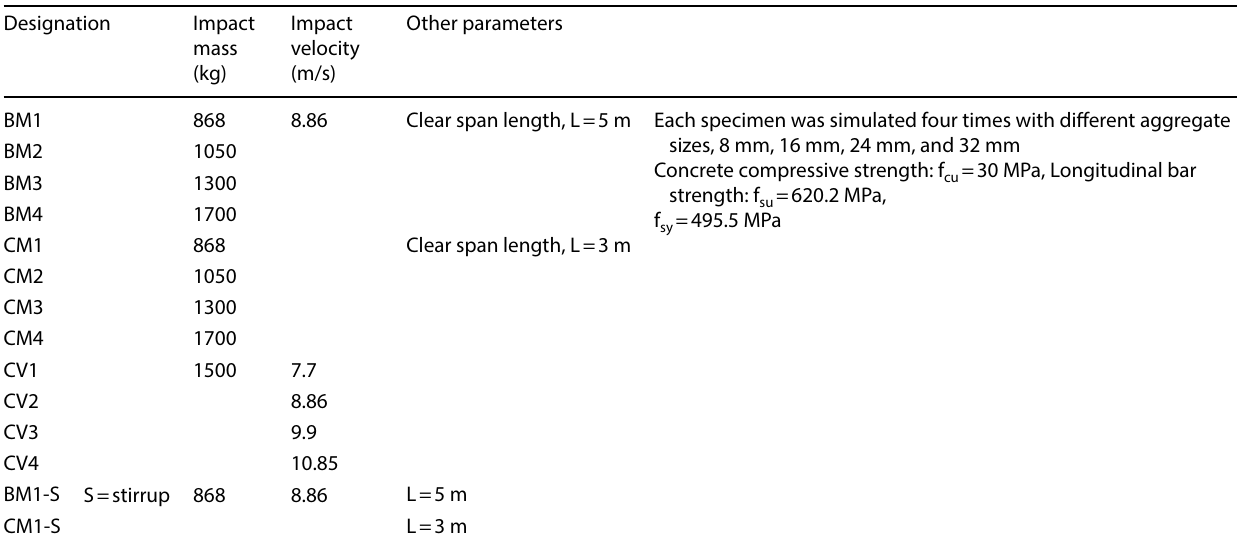
Table 1 Specimens for parametric study Designation Impact